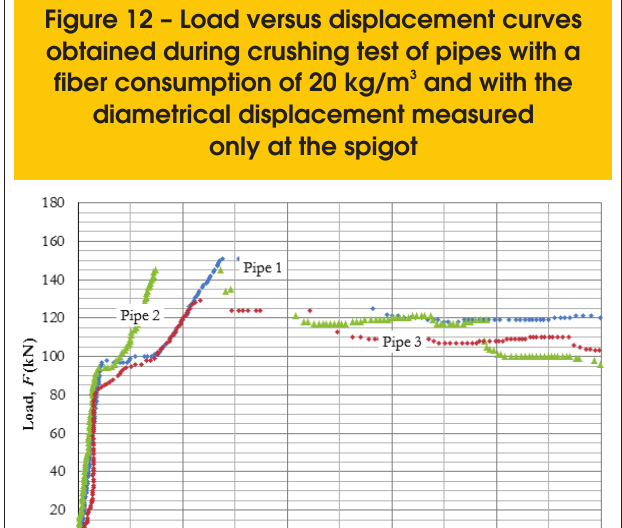
Figure 12 – Load versus displacement curves obtained during crushing test of pipes with a 3 fiber consumption of 20 kg/m and with the diametrical displacement measured only at the spigot